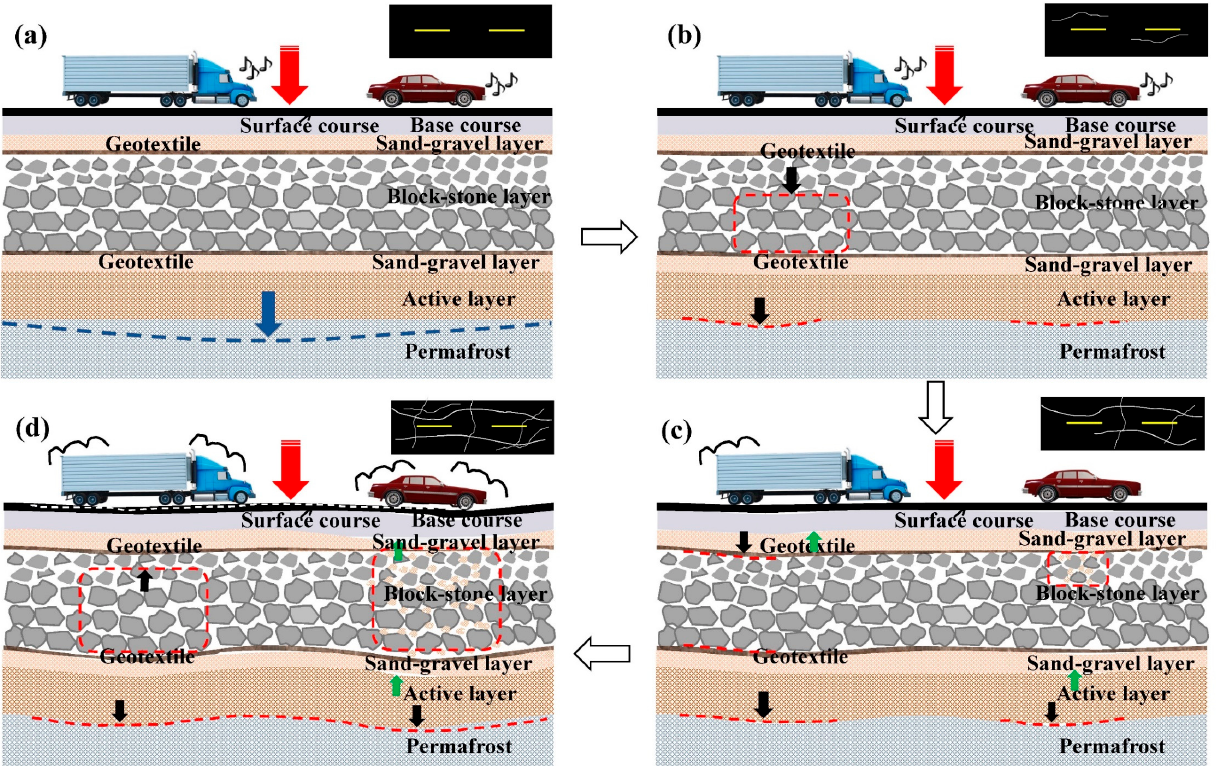
Figure 15. Progressive formation of block-stone embankment damage: ( a ) shows that the action of various influencing factors causes the thawing of the permafrost beneath the embankment; ( b ) shows the active layer changes that affected the embankment; ( c ) shows the worsening damage to the embankment; ( d ) shows that as the damage progressed, the embankment structure was greatly damaged. The red arrows indicate the influence of the external environment on the embankment (such as sun exposure and vehicle rolling), and the other dotted boxes and arrows are used to facilitate reading .